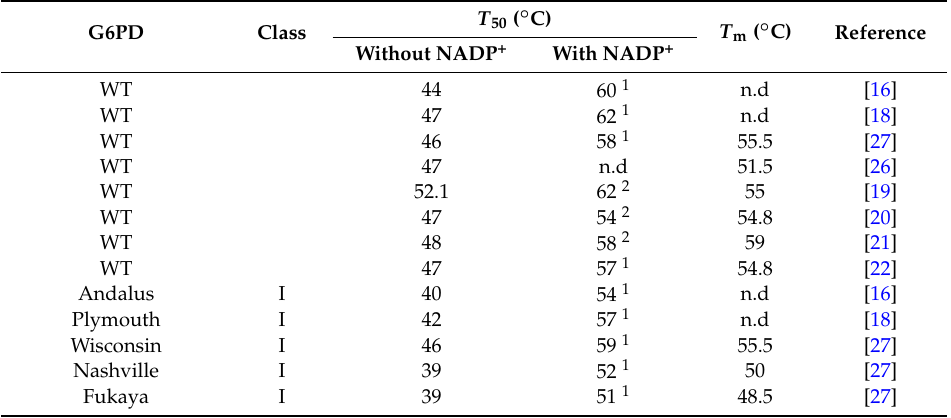
Summary of thermal inactivation and melting temperature assays for the WT and G6PD